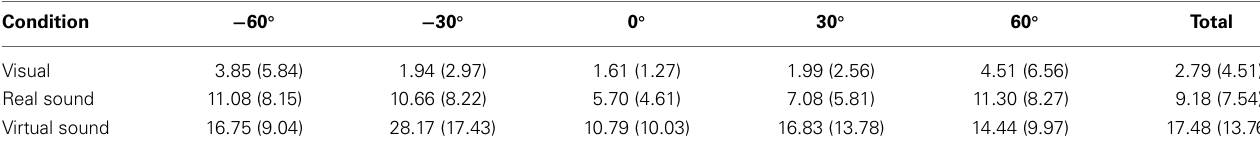
Table 3 | Mean absolute azimuth error in degree (standard deviations in parenthesis) for each rendering condition as a function of stimuli